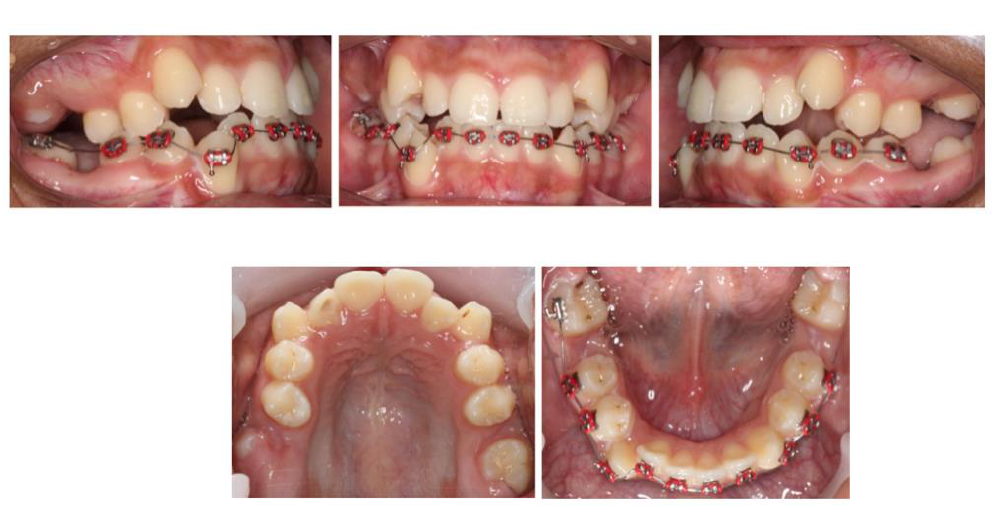
Figure 2. Six months following the extraction of all first permanent molars (FPMs). Note the favorable spontaneous eruption of the second permanent molars. The placement of full fixed appliances was postponed until complete eruption of the second permanent molars.